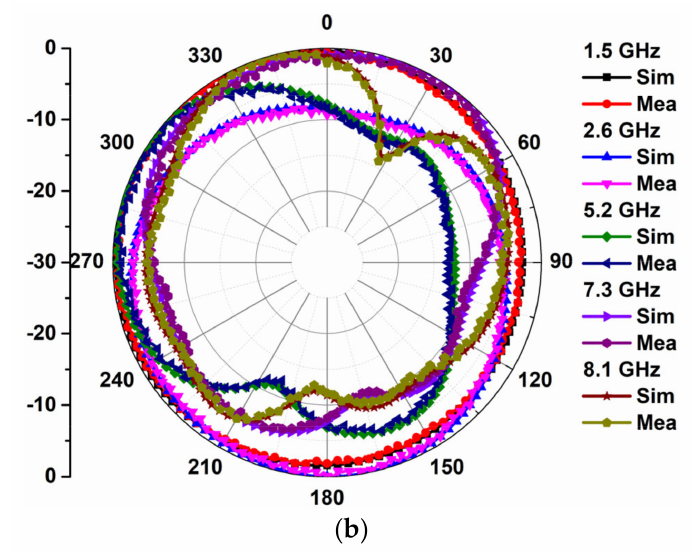
Figure 12. Simulated and measured radiation pattern comparison. ( a ) E-Plane and ( b )